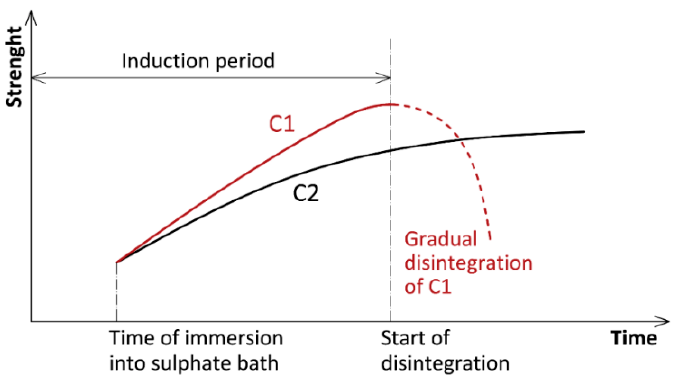
Figure 2. Graph of the principle of strength development of the more (C2) and less (C1) sulfate resistant concrete in time.